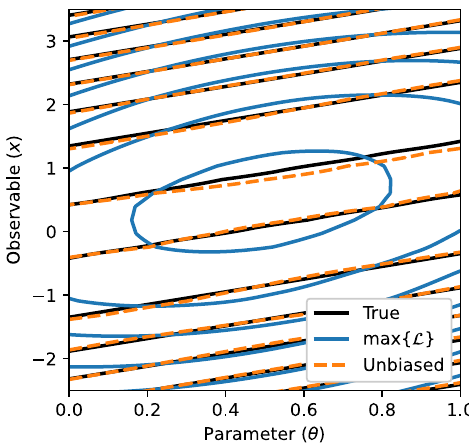
Fig. 3 Joint PDFs for the example described in Sect. 5.1. The “true” joint PDF is shown in black. Fitting to the training dataset with dis- crete parameter values results in the blue PDF, which is different from the desired form. Adding additional constraints to the fit requiring (cid:20) p ( x | θ) dx to be 1 at θ = 0 and θ = 1 yields the orange dashed line PDF instead, which is a good approximation of the true distribu- tion